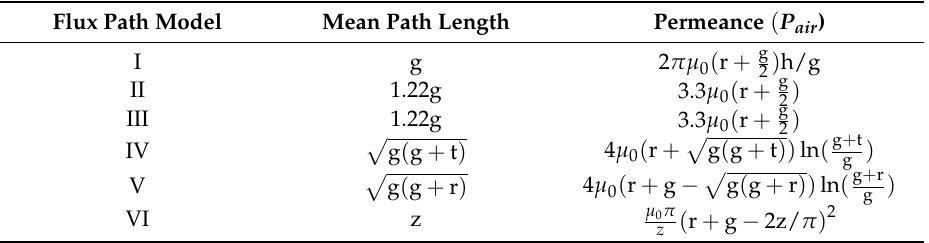
Table 1. The air gaps magnetic flux path model